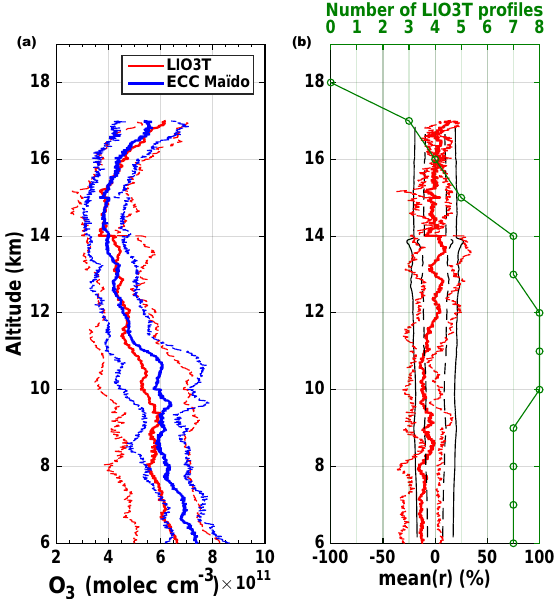
Figure 6. Same as Fig. 5 for NDACC/SHADOZ Gillot ECC sound- ings and full night-time LIO3T